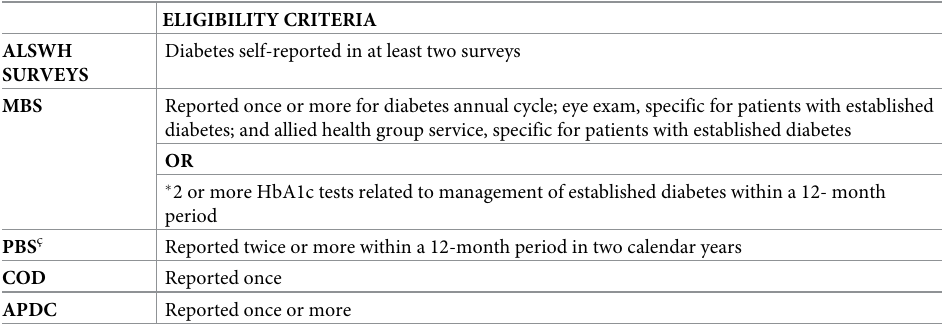
Table 1. Case ascertainment algorithm for